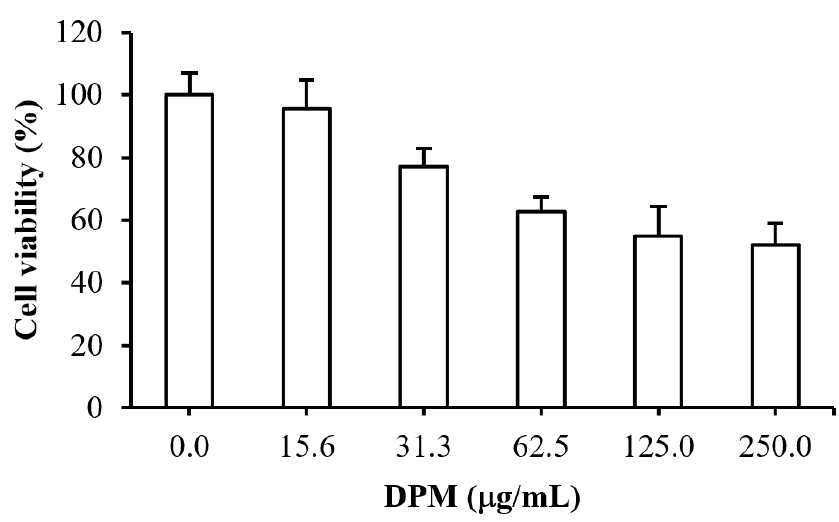
Figure 6. Cytotoxic effect of diphenylmethane on human hepatic HepG2 cells. DPM, diphenylmethane. Data are expressed as mean ± SD ( n = 3).